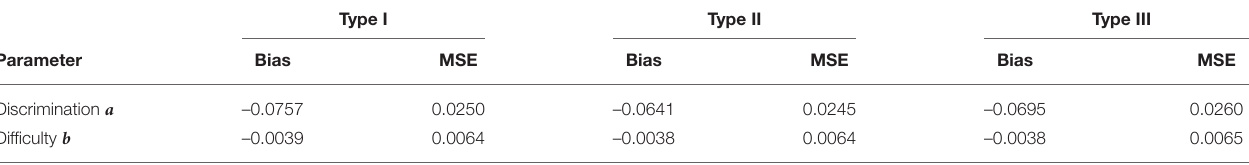
TABLE 5 | Average Bias and MSE for the item parameter estimates using three prior distributions in the simulation study 2.